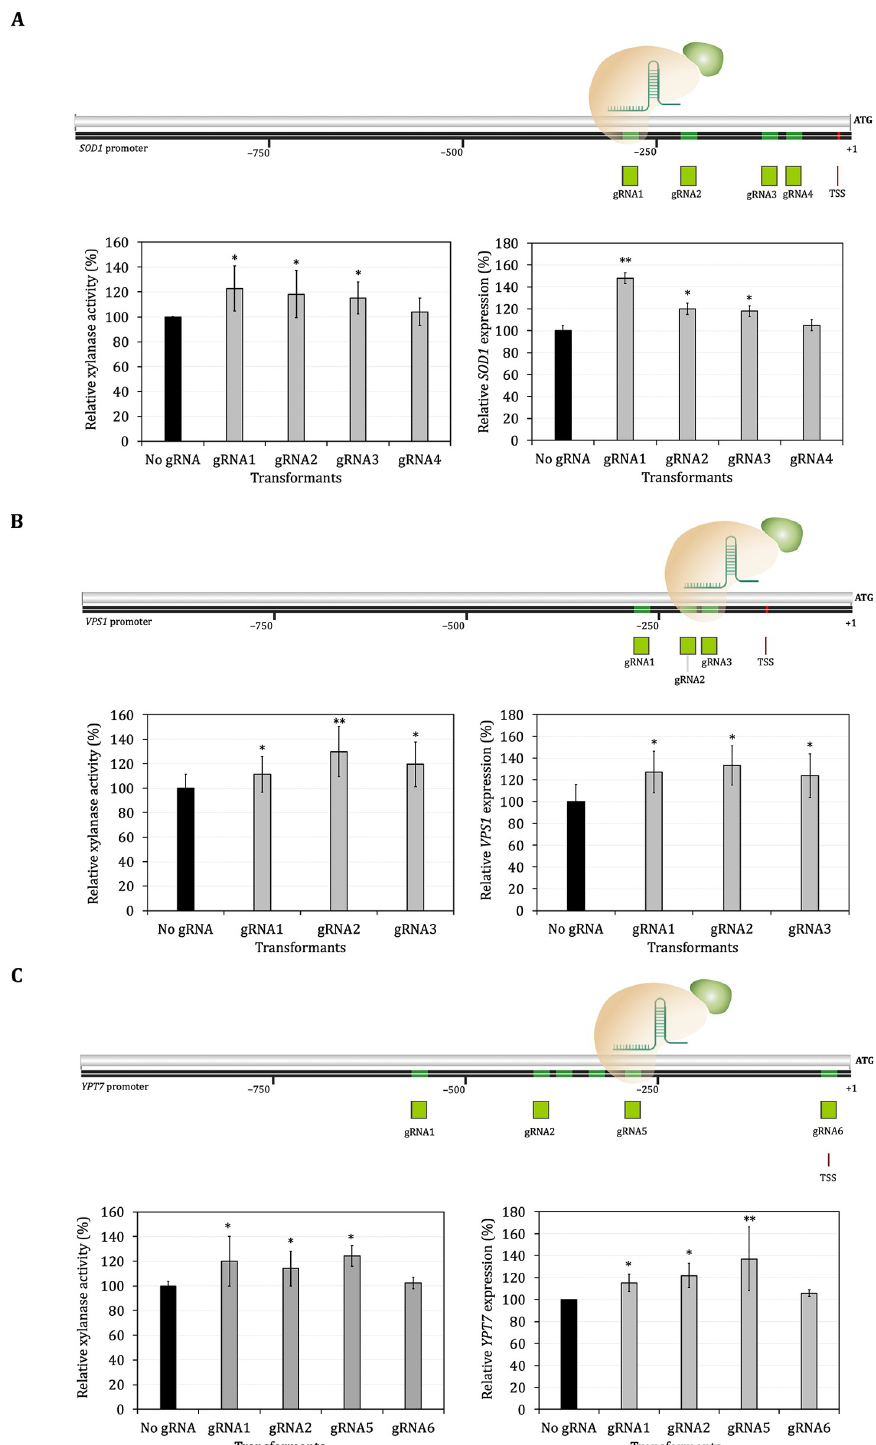
Fig 3. Targeting CRISPR-dCas9 to sequences upstream promoter of SOD1 (A), VPS1 (B) and YPT7 (C) and relative activity of xylanase activity (%U/OD) and relative gene expression level (%fold change) in recombinant yeast harboring CRISPR-dCas9 system. Data are shown as mean ± S.D. from three-independent biological replicate experiments ( n = 3). ACT was used to normalize gene expression. TSS is a putative transcription start site. Asterisks ( � ) indicate significantly altered expression profiles relative to the control Ot-dCas9-VP64 without gRNA (No gRNA) ( � p < 0.05 and �� p < 0.01).